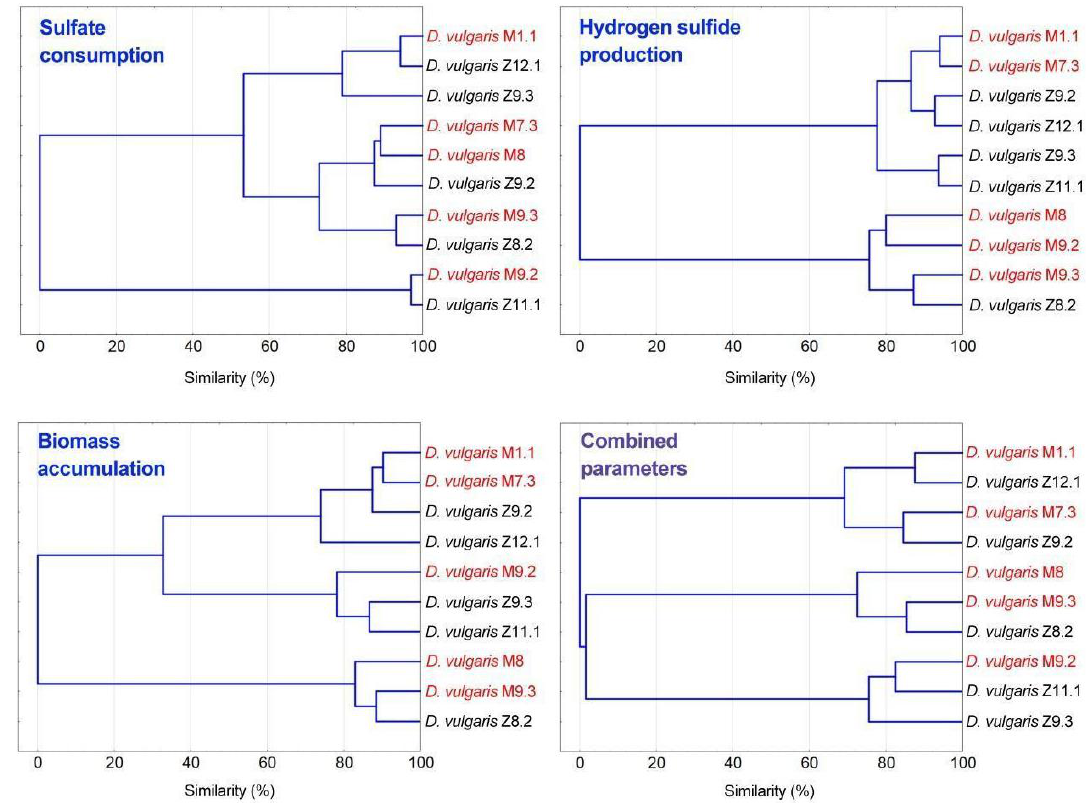
Figure 5. Cluster analysis of sulfate consumption, H 2 S production and biomass accumulation parameters.